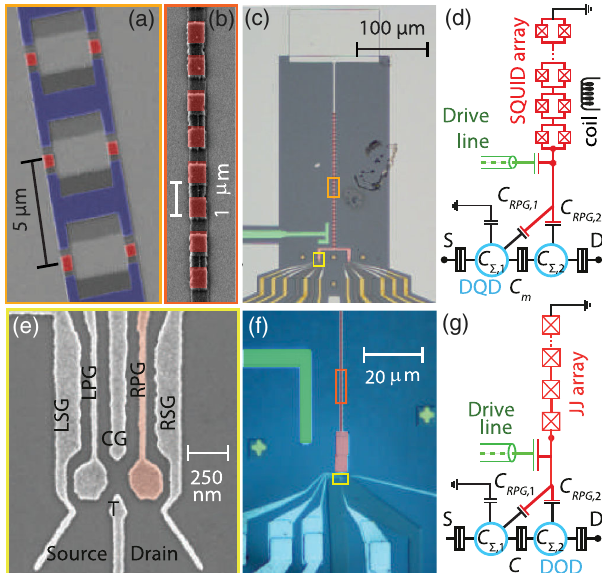
FIG. 1. Simplified circuit diagram and micrographs of the devices. (a) [(b)] False-colored SEM micrograph of a section of the SQUID [Josephson-junction] array resonator indicated by the light [dark] orange rectangle in (c) [(f)]. Josephson junctions in the array are highlighted in red. (c) False-colored optical micro- graph of the measured device described in Sec. II, with a SQUID array resonator (red), ground plane (light gray), fine (light gray), and coarse (gold) gates defining the DQD. (d) [(g)] Schematic of the device and control line indicating a simplified circuit diagram of the SQUID [Josephson-junction] array resonator (red), drive line (green), the DQD (cyan), and an external coil (black). C , RPG ; 2 C , C Σ , C Σ , and C are the capacitance between the QD 2 ; 2 ; 1 m RPG ; 1 [QD 1 ] and the resonator, total capacitance of QD 2 [QD 1 ], and interdot capacitance, respectively. (e) Scanning electron micro- graph of the areas indicated by yellow rectangles in (c) and (f) showing the DQD fine gates (light gray) on the GaAs mesa (dark gray). The plunger gate galvanically connected to the resonator is highlighted in red. (f) False-colored optical micro- graph of the measured device described in Sec. III, showing the substrate (dark blue), the superconducting structures including the Al fine gate forming the DQD (light blue), the Josephson- junction array (red), and the microwave feedline